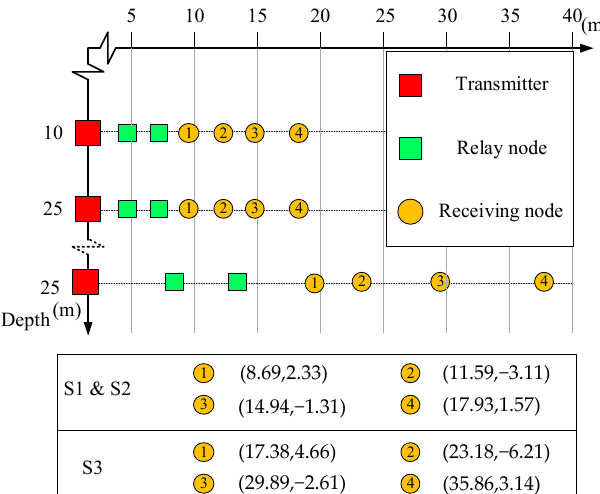
Figure 2. Diagram of simulation scenarios.